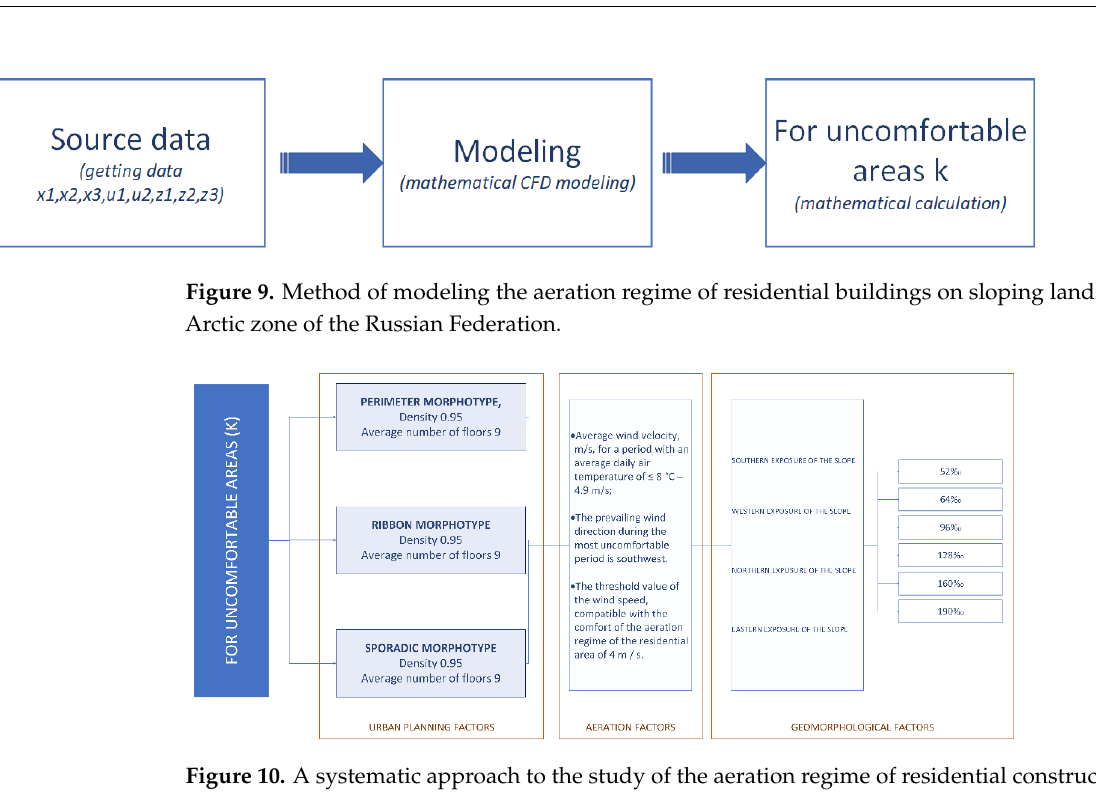
Figure 10. A systematic approach to the study of the aeration regime of residential construction on the sloping lands of the Arctic zone of the Russian Federation.